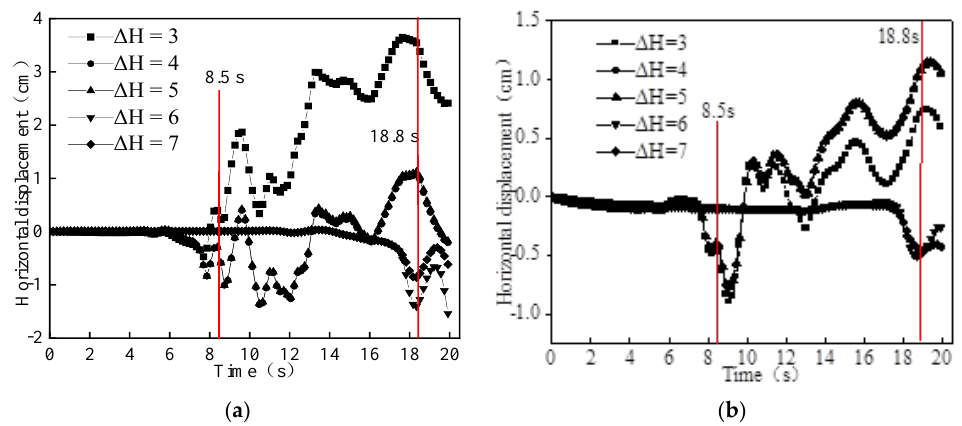
Figure 13. Time history of wall top displacement under different ∆ H : ( a ) step 1; ( b ) step 2. In general, laying the reinforcement near the lower layer is conducive to reducing the slope top displacement of step 1, while laying the reinforcement in the upper area is more beneficial to step 2. For the retaining wall as a whole, the reinforcement should be laid at the bottom and the top, respectively.